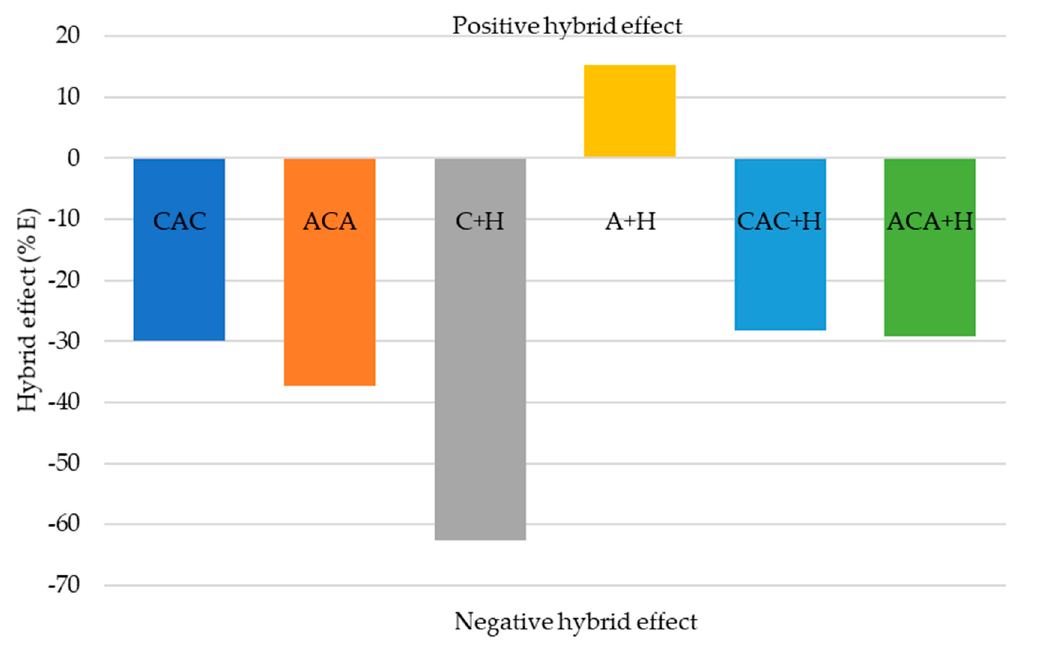
Figure 11. The percentage changes in absorbing total energy due to hybridisation.